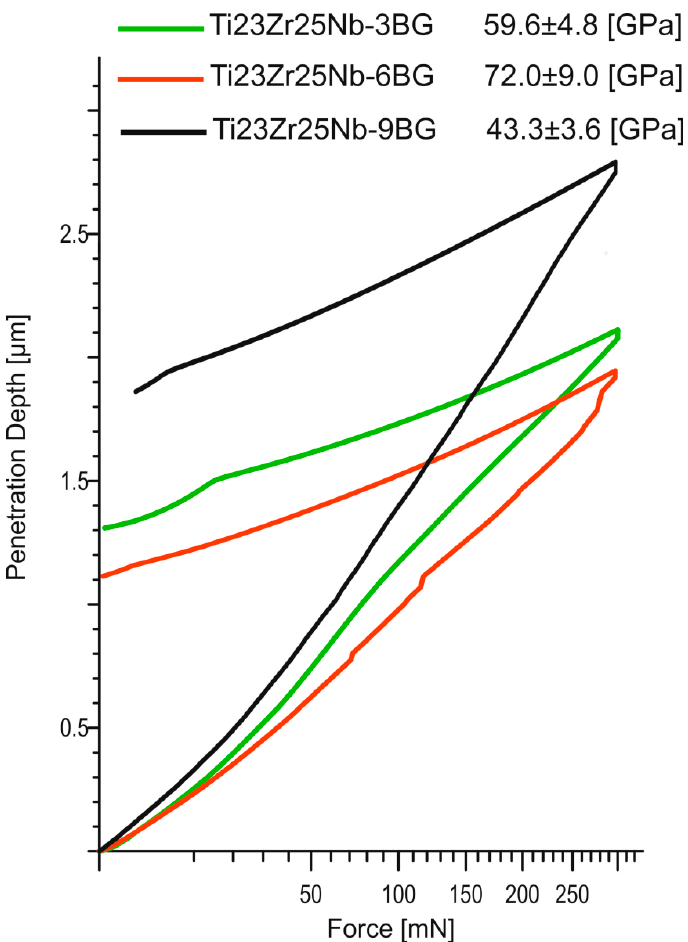
Figure 10. Load-depth curves of bulk Ti23Zr25Nb-based composites with the 3, 6, and 9 wt.% 45S5 Bioglass content. Table 4. Vickers hardness (HV0.3), surface free energy (SFE), dispersive and polar parts of SFE, diiodomethane, and glycerol contact angles for Ti23Zr25Nb-based composites with the 3, 6, 9 wt.% 45S5 Bioglass and 1 wt.% Ag, Cu, Zn content in contrast to the Ti23Zr25Nb alloy. Sample HV0.3